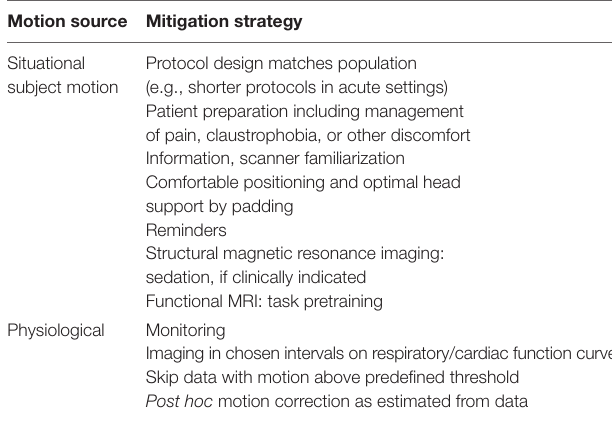
TABLe 4 | Common sources of motion artifacts and practical